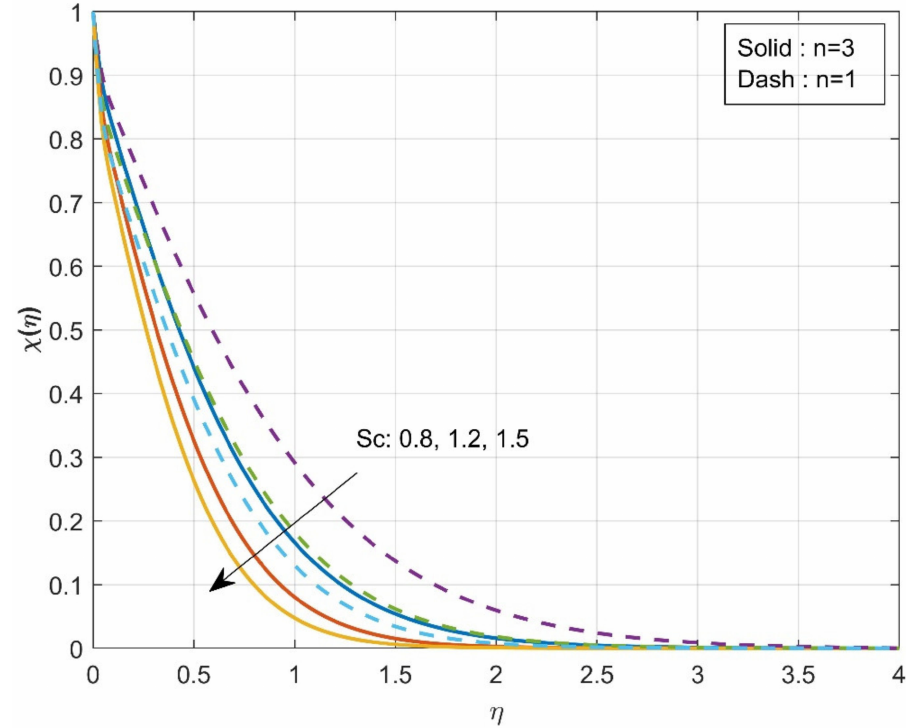
Figure 7. Influence of Sc over concentration χ ( η )